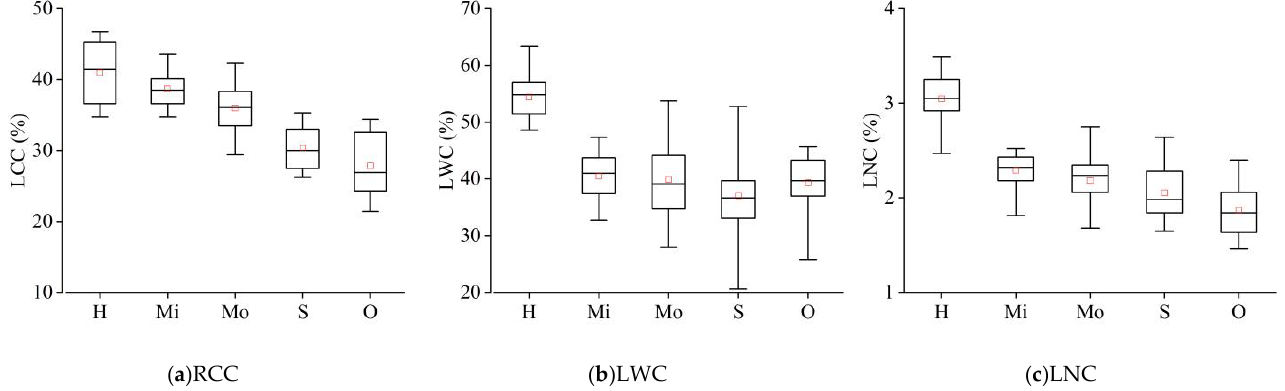
Figure 4. Biochemical parameters of moso bamboo leaves at different damage levels. Although all factors showed clearly descending trends with the deterioration of damaged severity, they still had great variations within the same severity group and sometimes were not significantly different among severity groups. As shown in Table 2, the difference in RCC between different severity groups was significant with the exception of that between healthy and mildly damaged leaves and that between severely damaged and off-year leaves. For LWC, the healthy leaves were significantly distinguishable from damaged and off-year leaves. However, the difference in LWC between damaged and off-year groups was not statistically significant. Different damage severity groups also showed significant difference in this factor. As for LNC, the differences between healthy, damaged, and off-year leaves were significant with the exception of the difference between mildly and moderately damaged leaves. Table 2. The significance levels of differences in RCC, LWC, and LNC between different severity